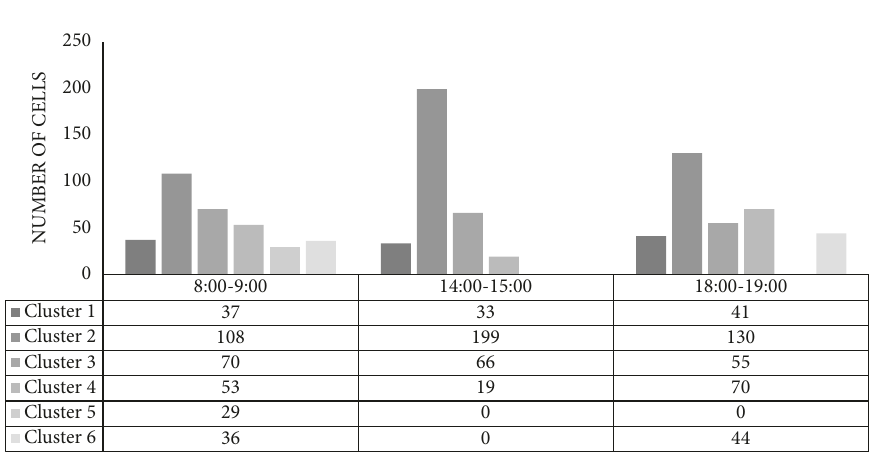
Figure 8: Clustering results for the number of cells by various times of